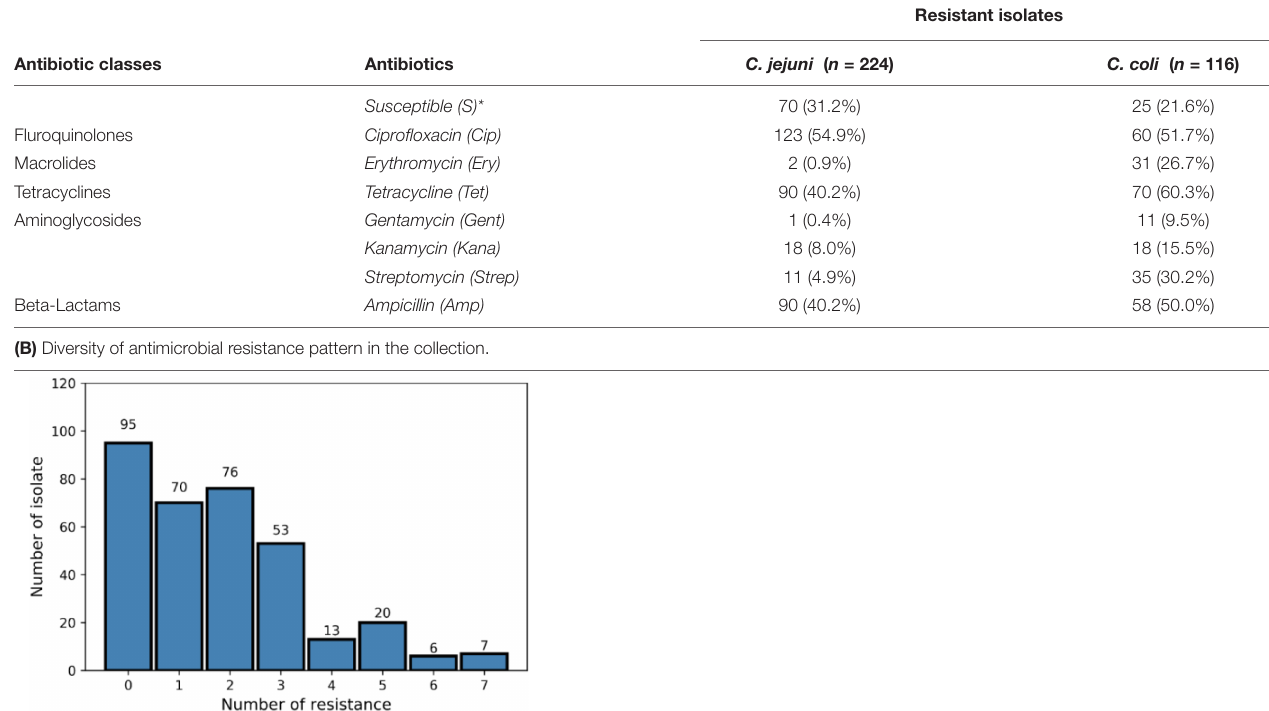
(A) Antimicrobial susceptibility patterns of Campylobacter isolates used in the present study. Antibiotic